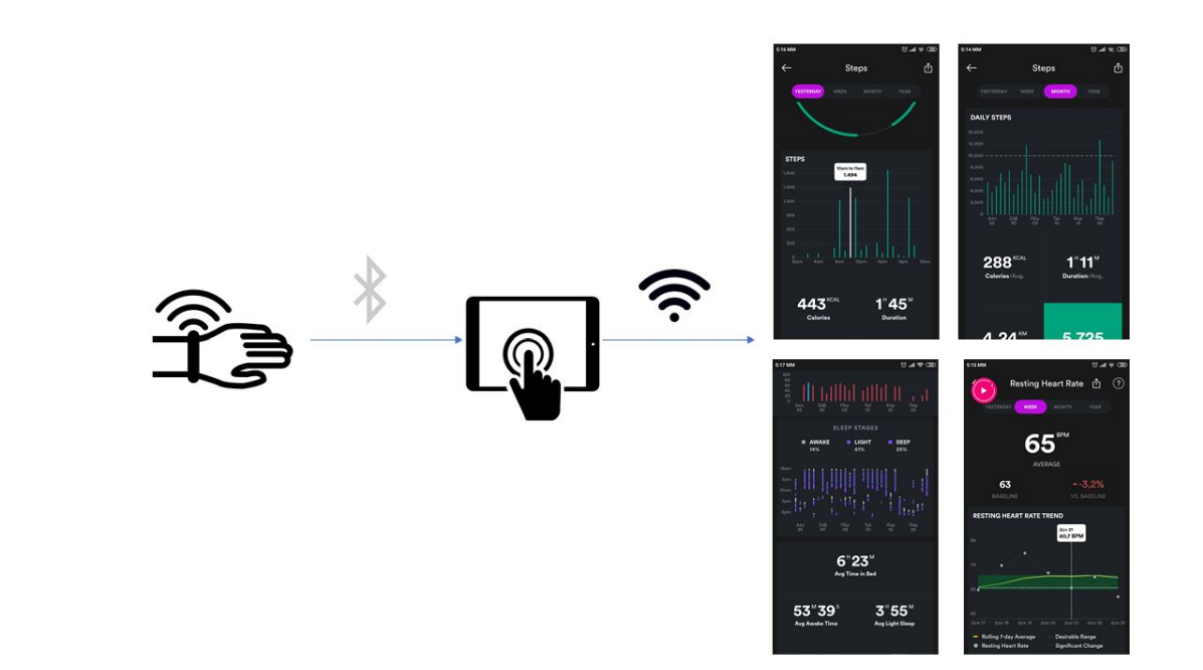
Figure 4. Wearable devices used to evaluate patient protocol